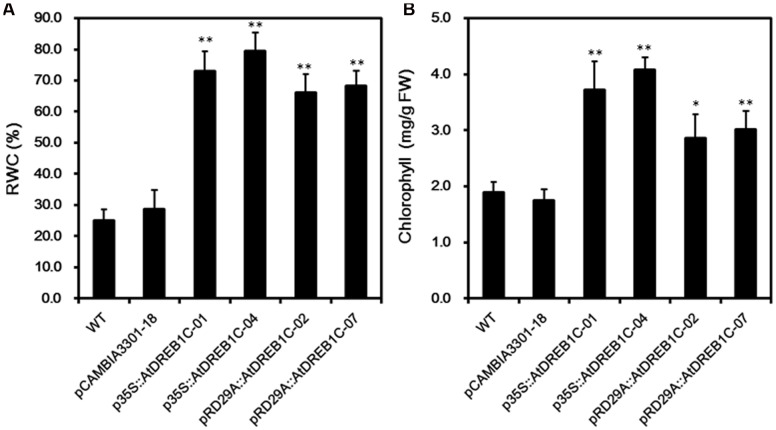
Effects of drought stress on relative water content (RWC) (A) and chlorophyll content (B) in WT and transgenic S. miltiorrhiza plants after withholding watering for 9 days. WT, wild type. The transgenic lines are indicated by the construct names followed by the line number: p35S::AtDREB1C-01 refers to p35S::AtDREB1C line 01 and so on; pCAMBIA3301-18 was used for the positive control. Bars represent the mean + SE of three independent experiments. ∗Significantly different at the P < 0.05 level compared to WT. ∗∗Significantly different at the P < 0.01 level compared to WT.